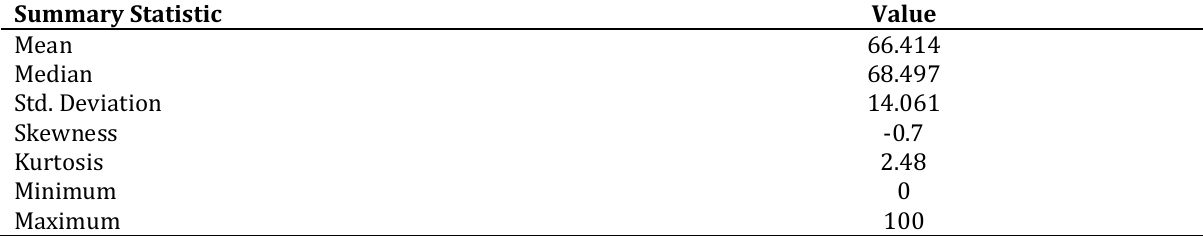
Table 18: Summary statistics of the level of sensitivity for warehouse performance Summary